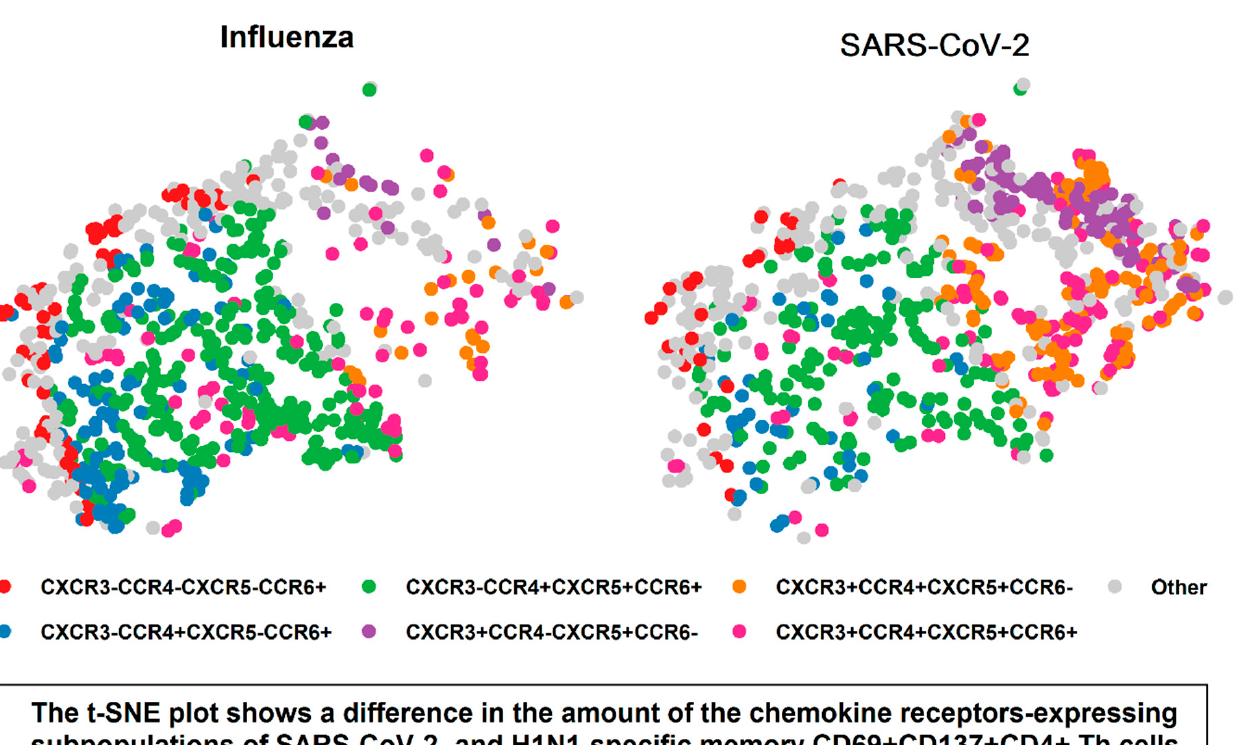
Figure 5. The t-SNE plot of different chemokine receptors-expressing subsets of SARS-CoV-2- and influenza-specific memory CD69+CD137+ CD4+ Th cells. The t-SNE analysis was performed using the cell fluorescence data from H1N1 and SARS-CoV-2-stimulated samples. A random sample ( n = 800) was selected from each group. t-SNE was performed using R version 4.0.0. The perplexity parameter was set to 40. The iteration number was